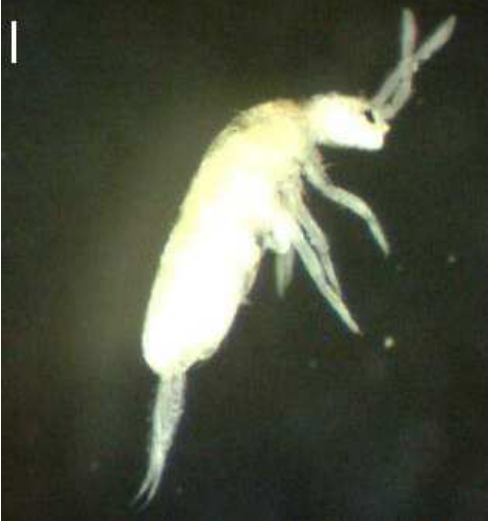
F IGURE 9. Body shape of P. octopunctata (scale: 1000 µm)